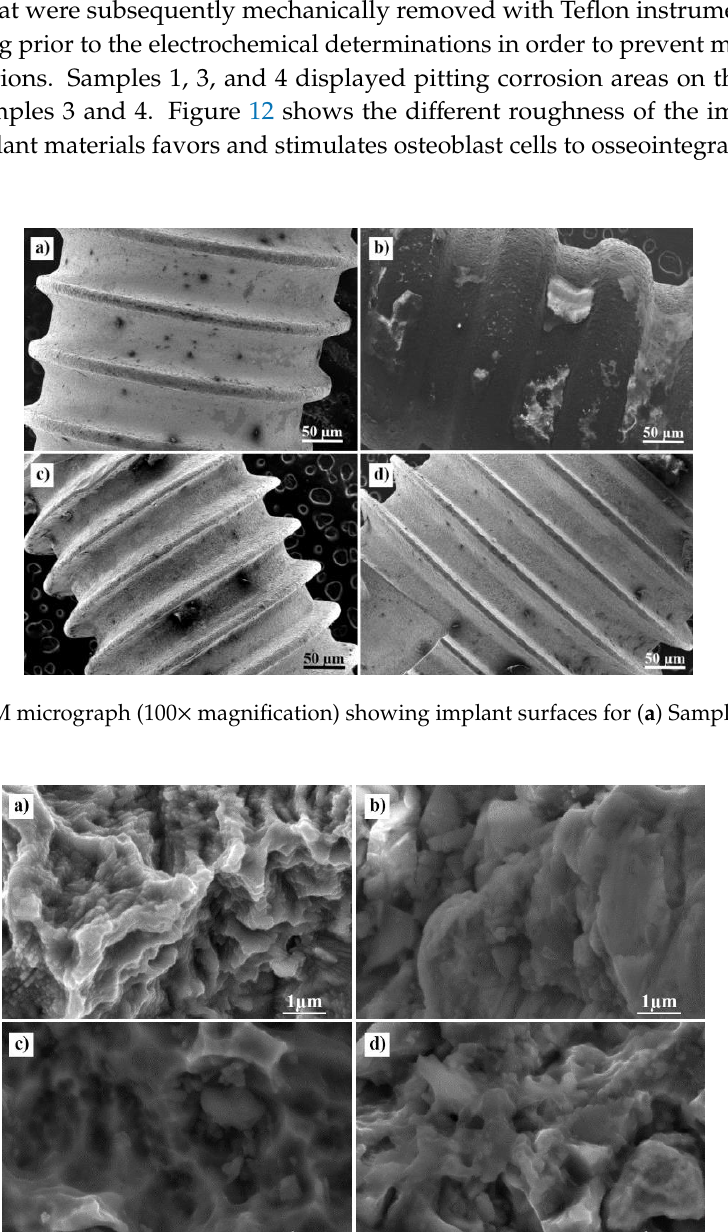
Figure 13. Relative composition of the atomic elements determined through EDS for the implanted materials: ( a ) Samples 1, ( b ) 2, ( c ) 3, and ( d ) 4.